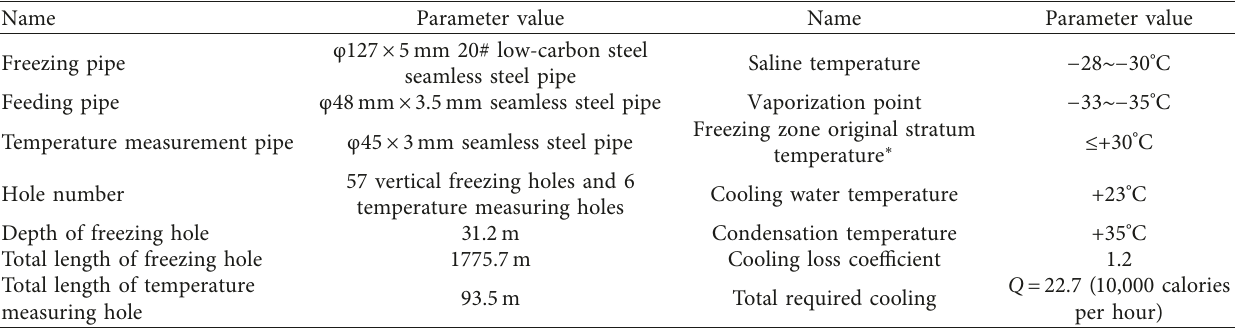
Table 2: Design parameters of verticle ground freezing.